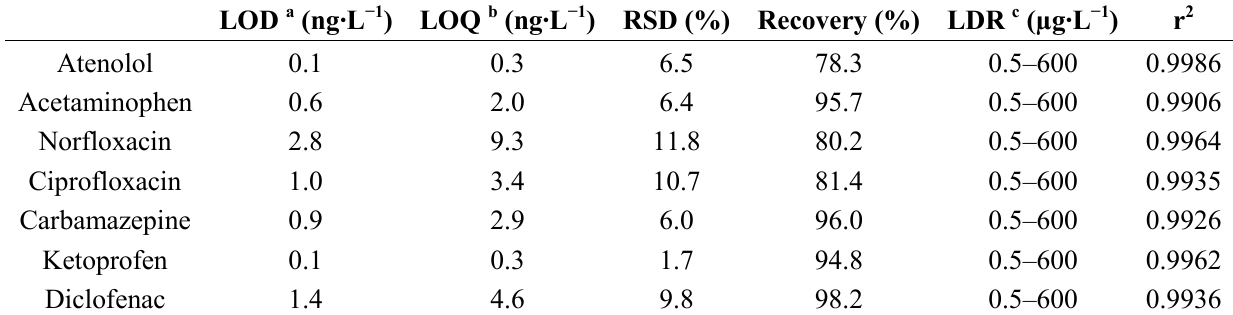
Table 3. Analytical parameters for SPE-LC-MS/MS